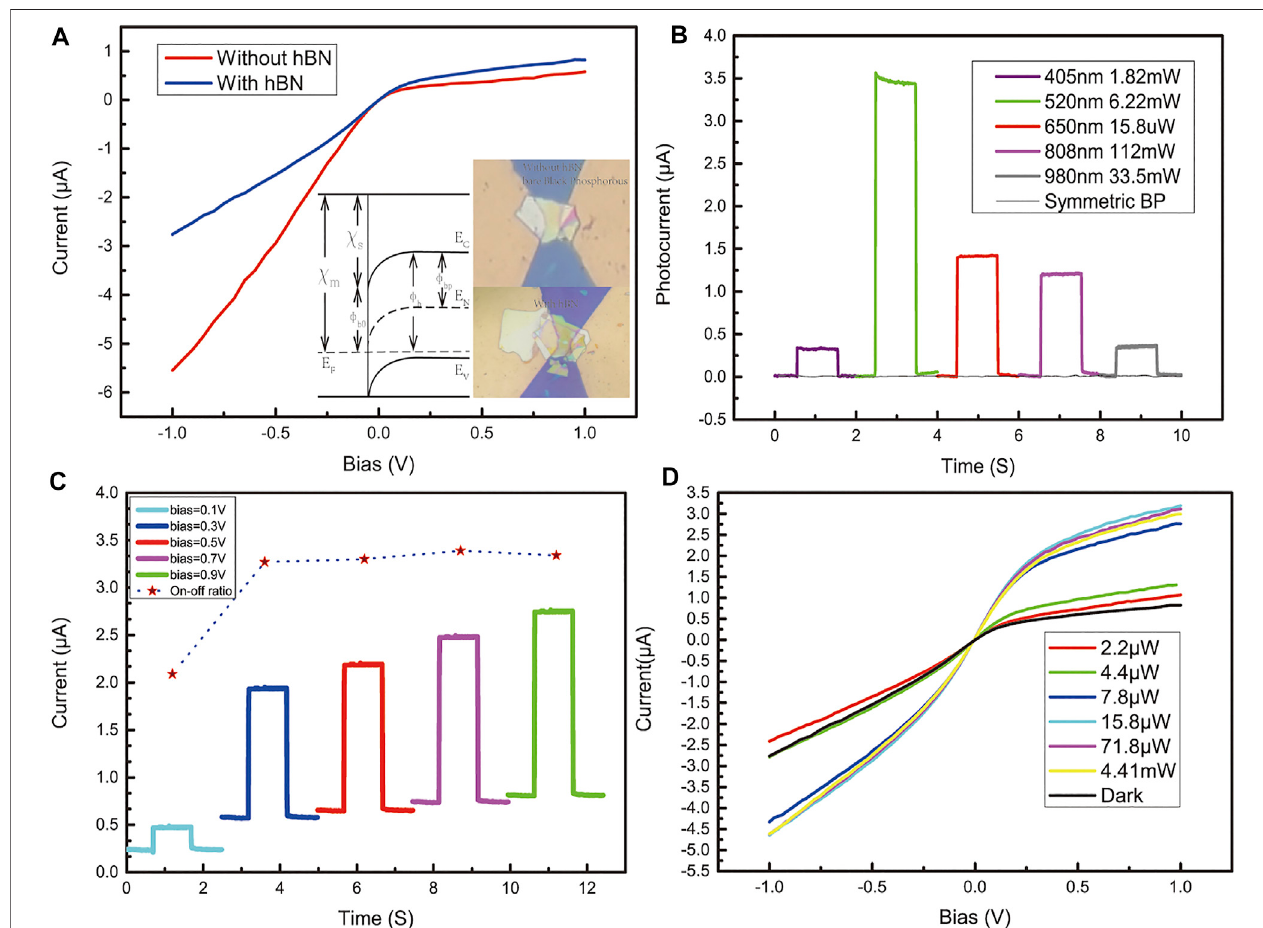
FIGURE 1 | Electrical feature and photocurrent of asymmetric BP. (A) Voltage-ampere characteristic curve of symmetric and asymmetric BP. (B) Saturable absorptionphotocurrentofasymmetricBPforvariouswavelengthsinthevisiblewaveband. (C) On-offandphotocurrentofasymmetricBPwithdifferentbiasvoltage. (C) Voltage-ampere characteristic curve of asymmetric BP under a 650-nm laser with increasing